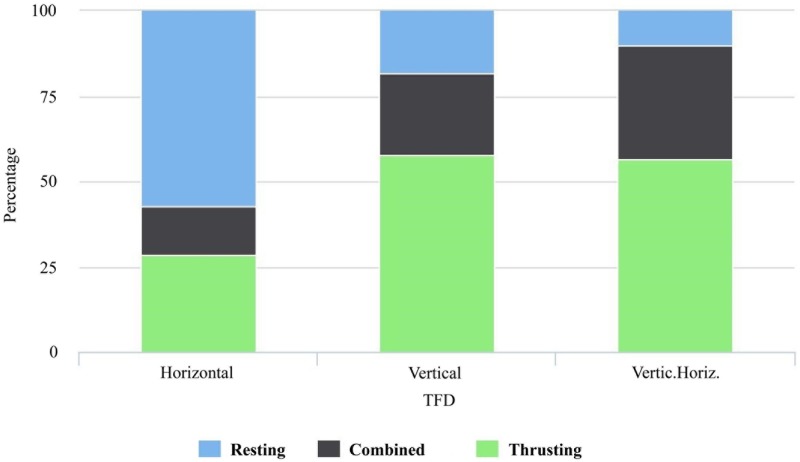
Tool functioning direction (TFD) and action.Bar plot of TFD grouped by action.